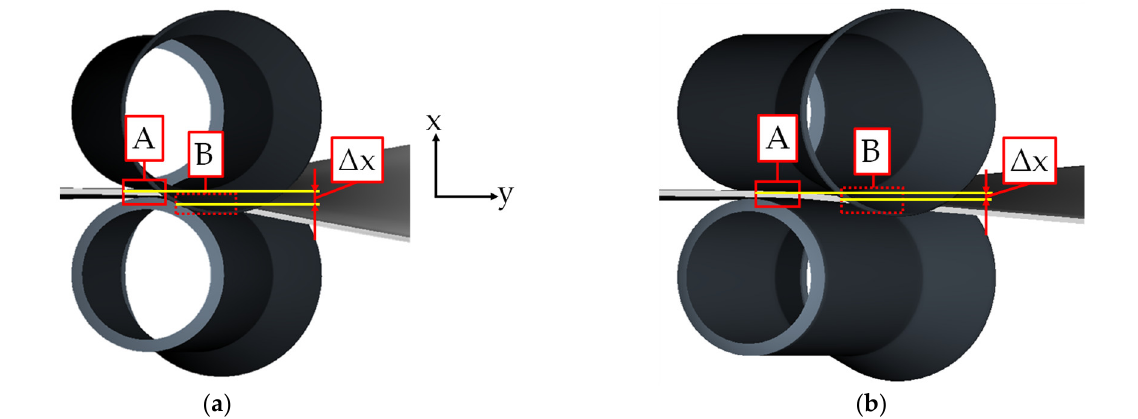
Figure 16. Lateral view: ( a ) Skew angle φ = 10° and ( b ) Skew angle φ = 20°.